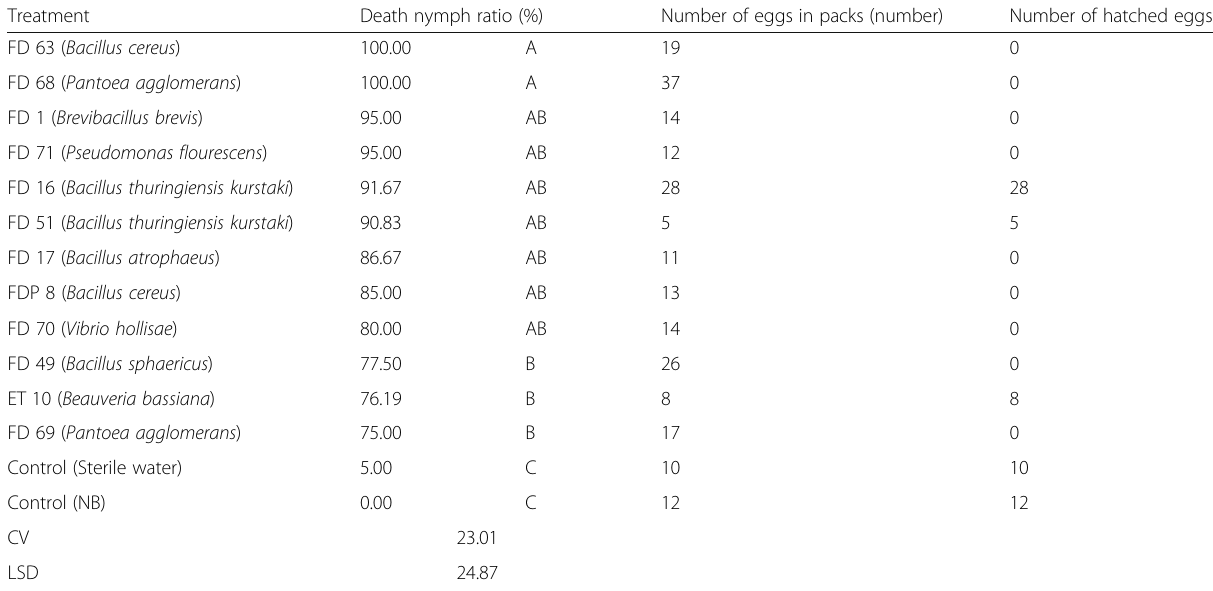
Table 2 Efficacy of some entomopathogen bacterial strains and fungal isolate on nymphs of Halyomorpha halys under controlled conditions after 264 h